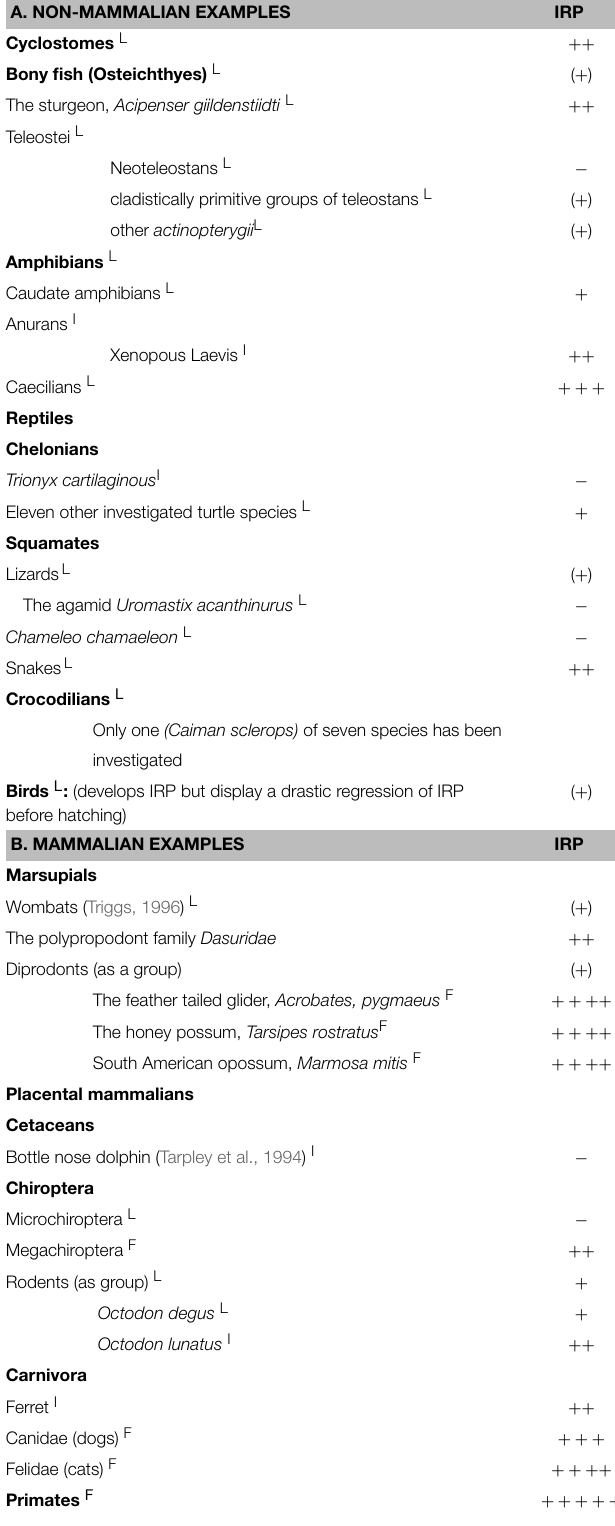
TABLE 1 | Ipsilateral retinal projections (IRP) in